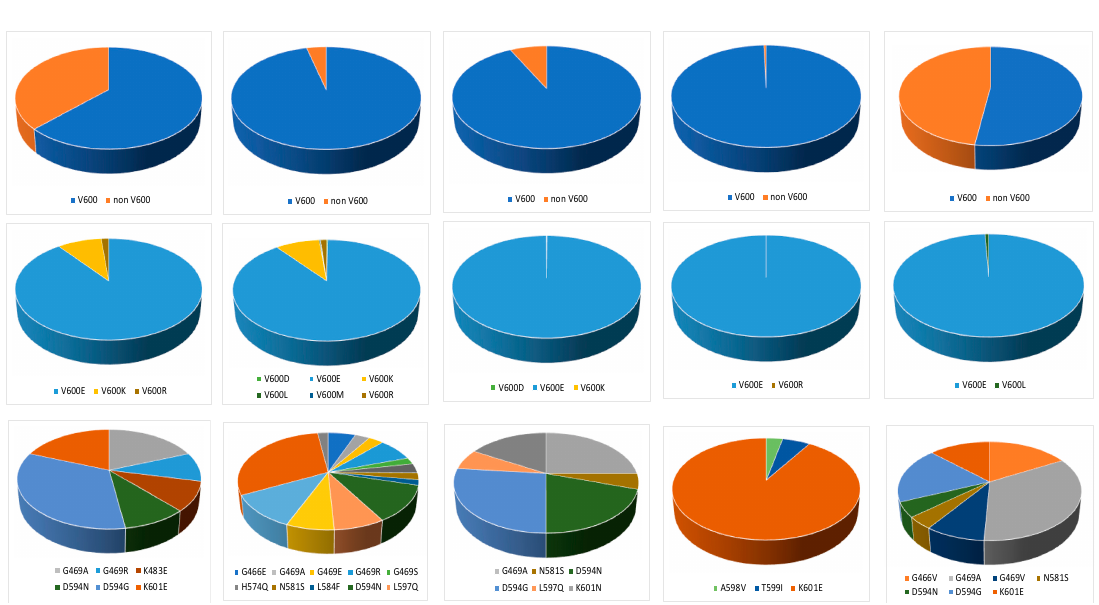
Figure 4. Oncogenic mutations of BRAF on valine 600 (V600) or outside valine 600 (non-V600). For non-V600 mutations, we only show point mutations representing more than 2% of non-V600 alterations in the different malignancies.